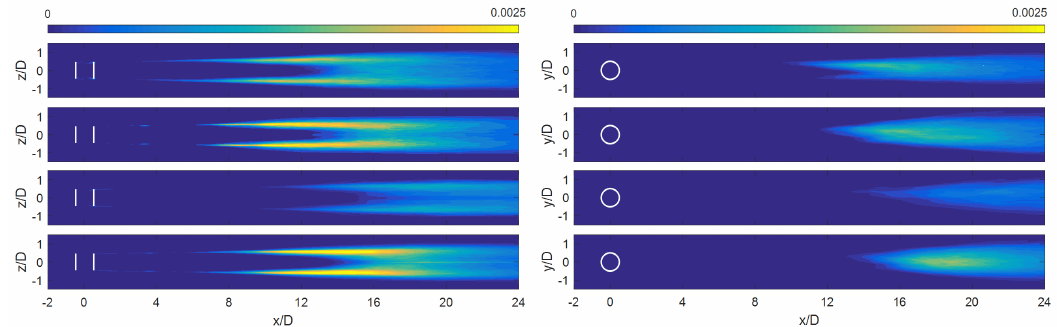
) in the central 0